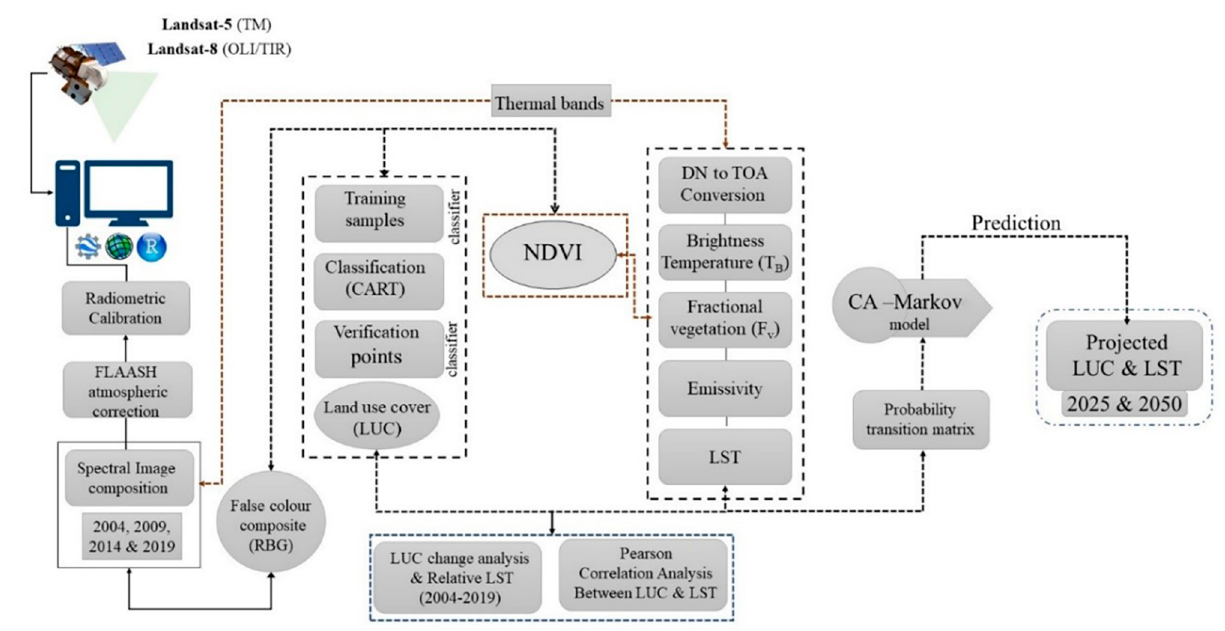
Figure 2. Methodology flow chart of this study.